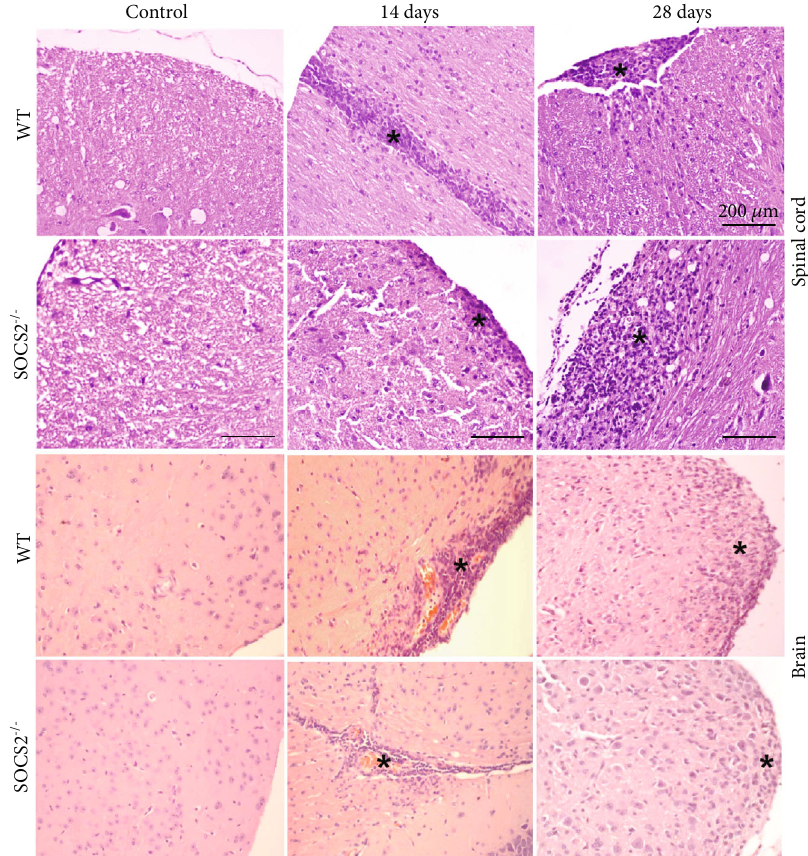
Figure 3: SOCS2 modulates in fl ammation in the CNS during EAE. Histology of brain (brainstem) and spinal cord sections from WT and SOCS2-de fi cient animals. Control mice with normal histological appearance. Brain, 14 days: EAE induced WT mice showing a locally extensive and intense in fi ltration of mononuclear cells (asterisk). EAE induced SOCS2 -/- mice with moderate perivascular in fl ammation (asterisk). Spinal cord, 14 days: EAE induced WT mice showing intense myelitis characterized by in fi ltration of mononuclear cells (asterisk). EAE induced SOCS2 -/- mice with mild to moderate myelitis (asterisk). Spinal cord at 28 days: EAE induced WT mice exhibiting mild to moderate meningomyelitis and EAE induced SOCS2 -/- mice showing locally extensive and intense meningomyelitis and demyelization (asterisks). Brain at 28 days: EAE induced WT mice exhibiting moderate encephalitis and induced SOCS2 -/- mice showing intense in fl ammatory in fi ltration (asterisks). Original magni fi cation: × 200 ( n = 6 animals per group). Data are representative of three independent